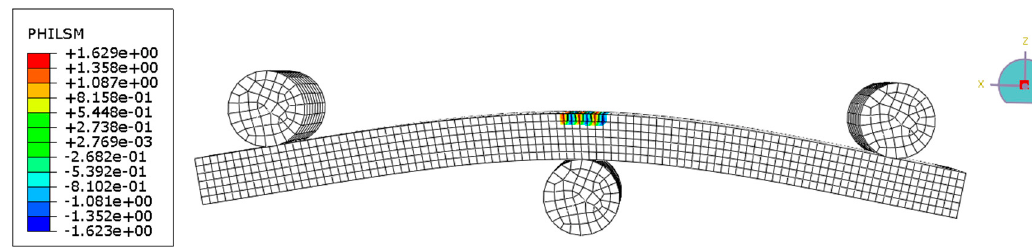
Figure 7. Damage dissipation energy for the extended finite element method model (T2).